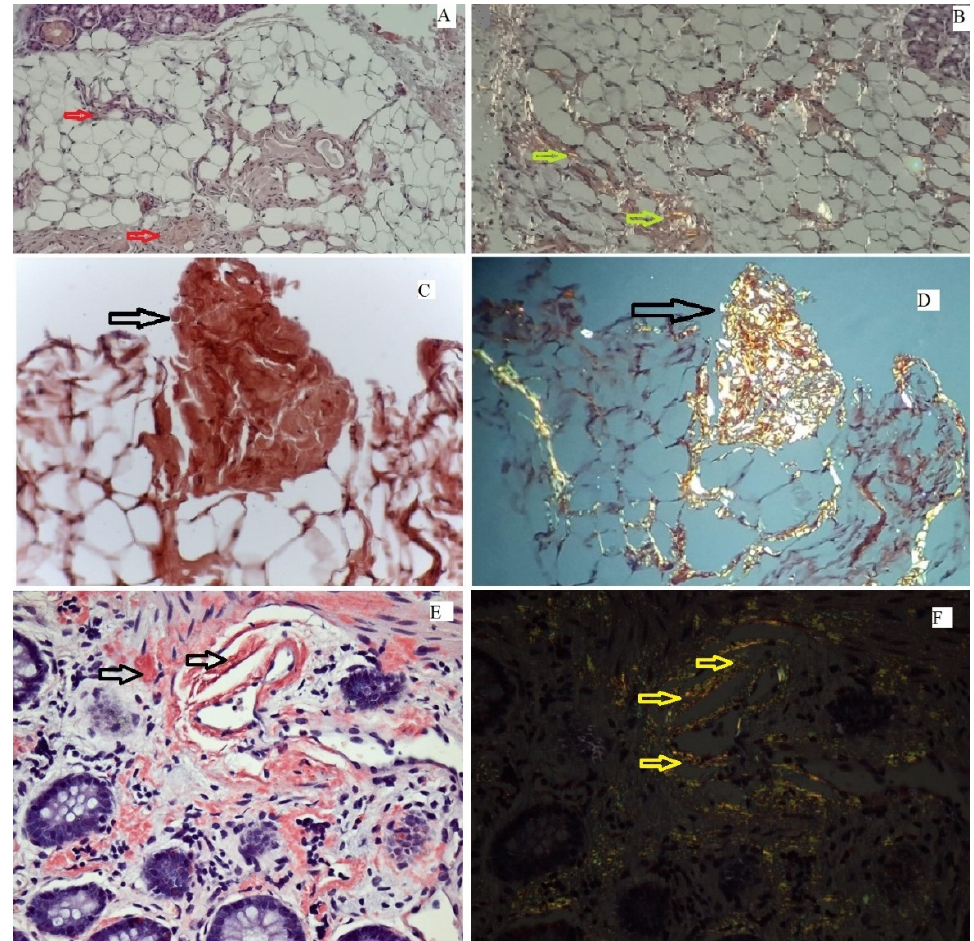
Figure 1. Anatomopathological main findings suggestive of cardiac amyloidosis . ( Upper panel ). Salivary glands biopsy, showing Congo red positivity (red arrows) ( A ), with apple green birefringence on polarization yellow arrows ( B ); ( Mid panel ). Abdominal fat pad, showing important Congo red positivity (black arrow) ( C ), with apple green birefringence on polarization (black arrow) ( D ); ( Lower panel ). Rectal biopsy, with important and diffuse infiltration with amyloid fibrils , Congo red positivity (black arrows) ( E ), with apple green birefringence on polarization (yellow arrows) ( F ).